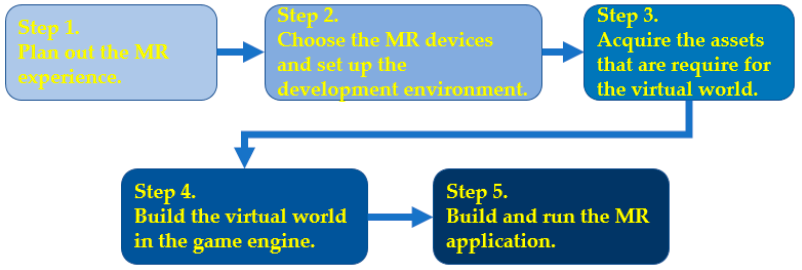
Figure 1. Workflow of the MR system.